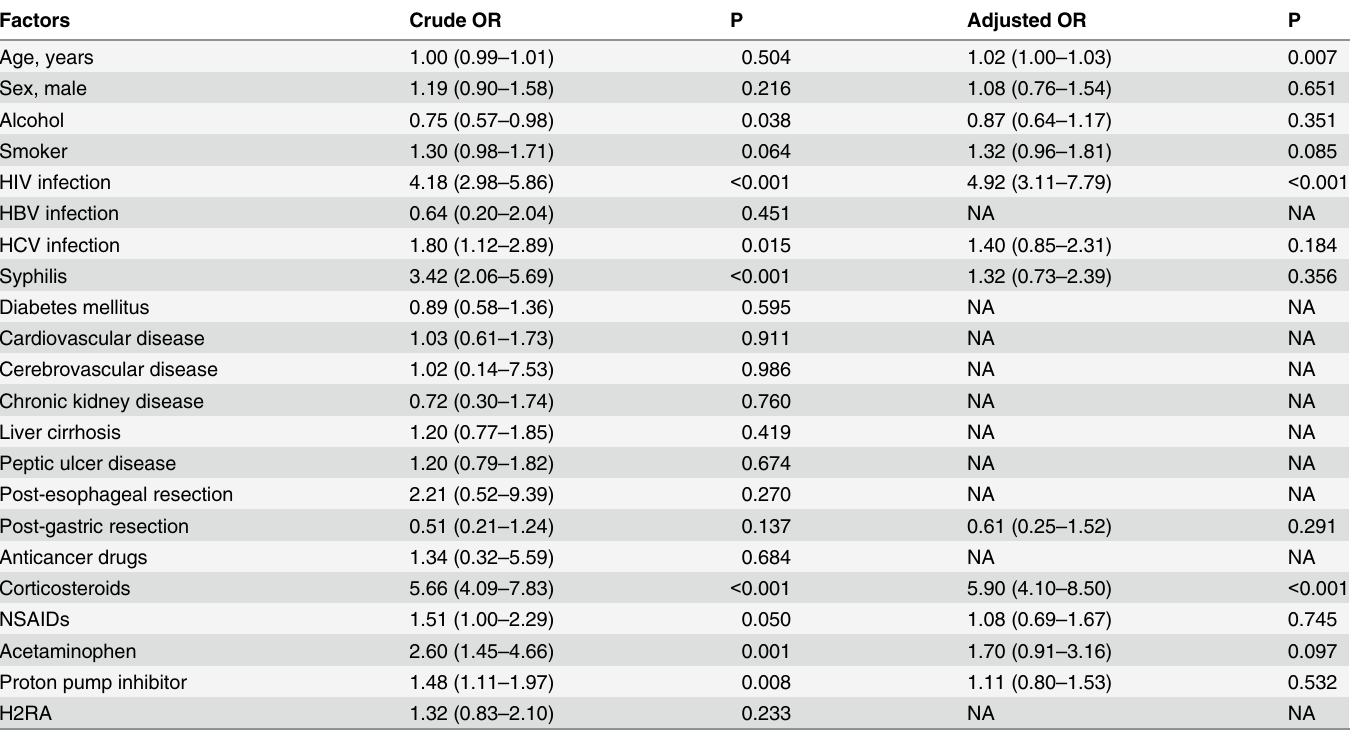
Table 3. Risk factors for candida esophagitis (n = 6,011). Factors Crude OR P